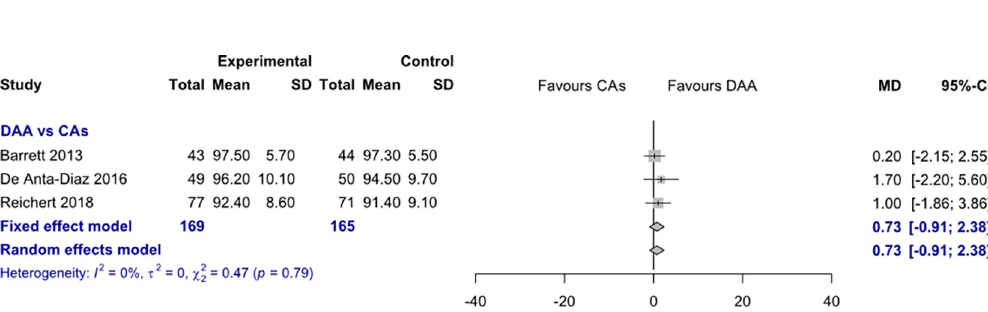
Fig 7. Comparison of the HHS 6 months postoperatively. DAA, direct anterior approach; CAs, conventional approaches; SD, standard deviation; MD, mean difference; CI, confidence interval.